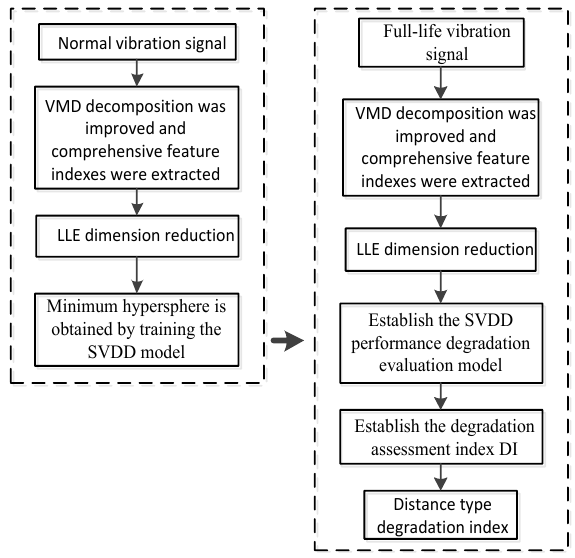
Figure 3. Overall process of degradation assessment.